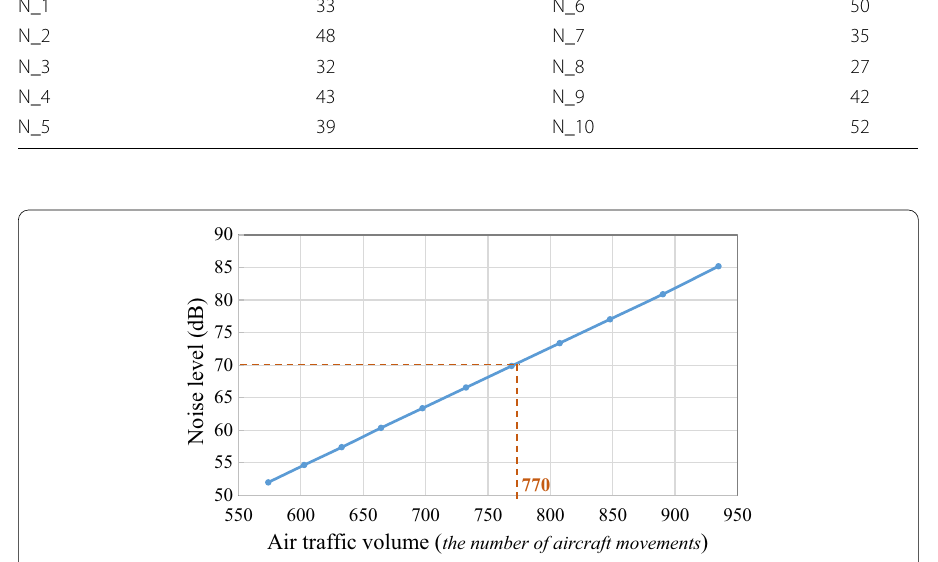
Fig. 7 The relationship of air traffic flow volume and